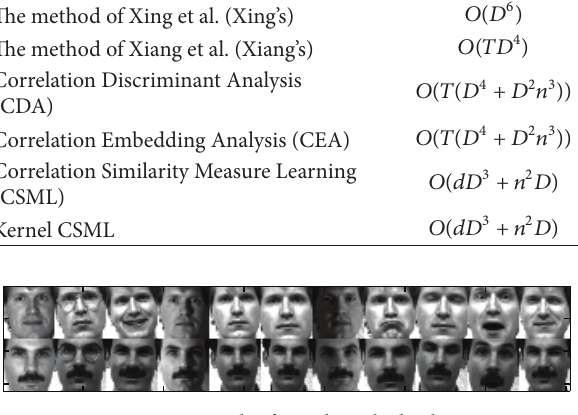
Figure 1: Samples from the Yale database.